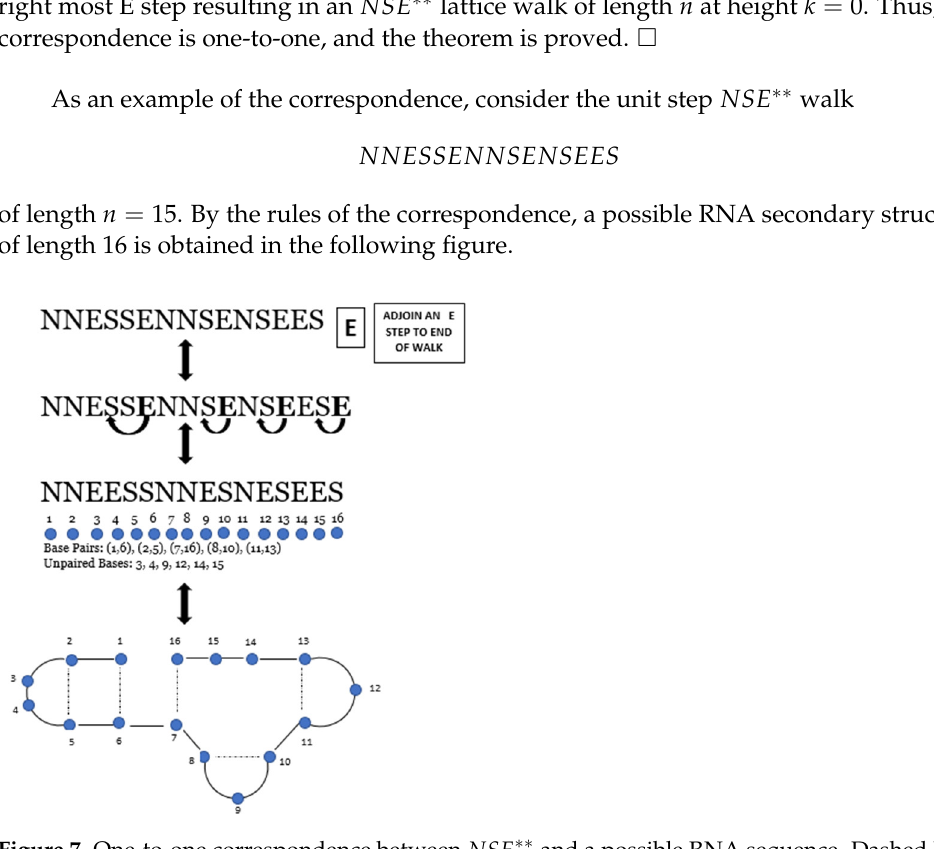
Figure 7. One-to-one correspondence between NSE ∗∗ and a possible RNA sequence. Dashed lines represent paired bases.